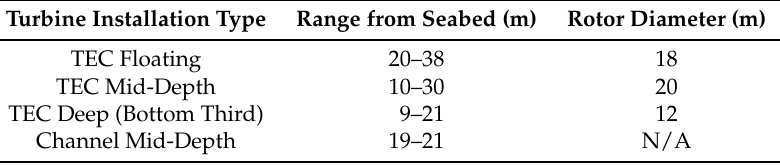
Table 3. Spatial averaging regions in the vertical direction for three TEC installation types and a narrow mid-depth sampling regime. Distances are relative to the